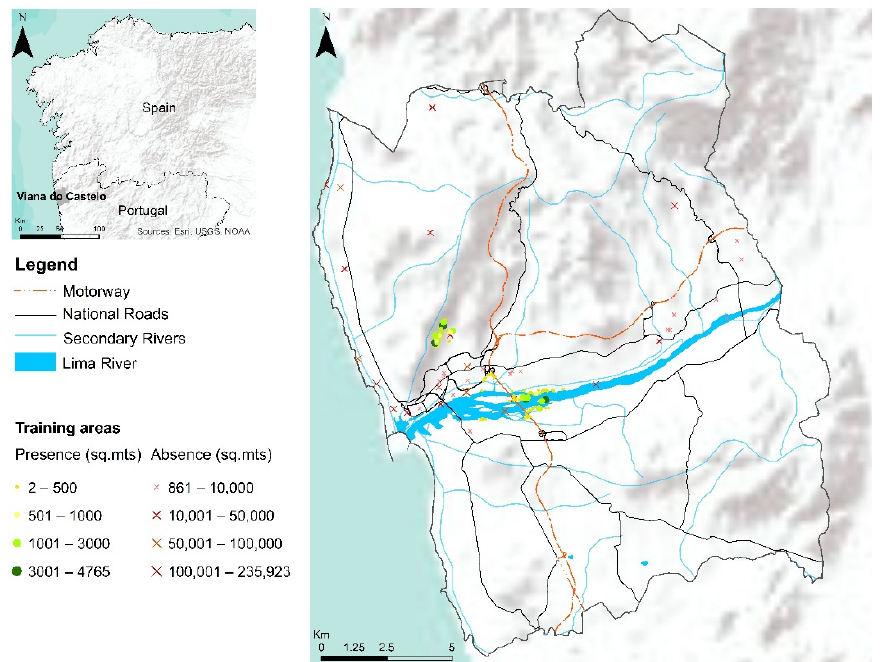
Figure 2. Location of the study area. Points represent the presence (green color) and X’s absence (in red) areas used for training the supervised classifier with a size proportional to the symbol dimension.